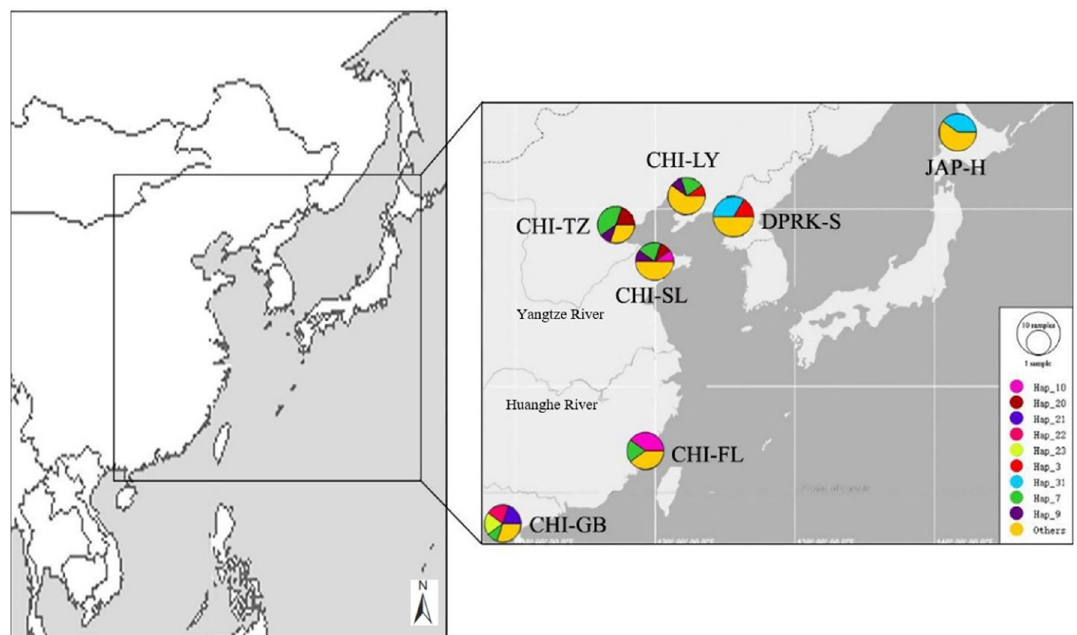
Figure 1. Frequency distribution of the COI haplotypes found among Manila clam populations. Pie charts show the distribution of COI haplotypes in the seven populations. Maps have been acquired from Google Maps. Map data ©2017 Google, SK Telecom, Zenrin. Pie charts were drawn using Popart 13,14 . Note, Sampling locations, CHI-LY (Ying Kou, China); CHI-FL (Lian Jiang, China); CHI-TZ (Zui Dong, Ch ina); CHI-SL (Lai Zhou, China); CHI-GB (Bei Hai, China); JAP-H (Hokkaido, Japan); DPRK-S (Sinuiju, North